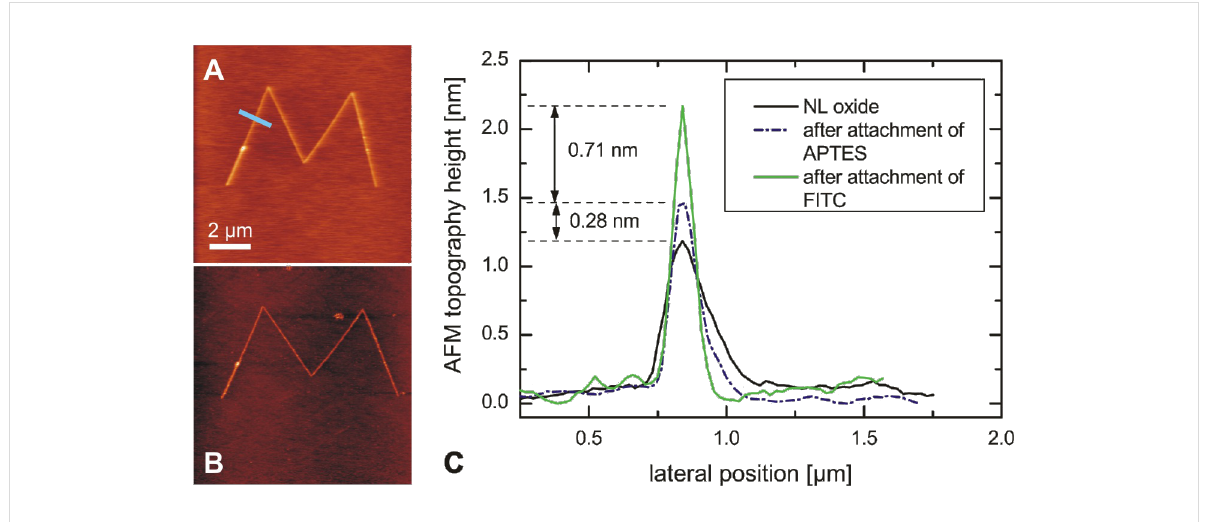
Figure 5: (A) and (B) AFM height images of LAO oxide line structures before any functionalization (A) and after binding of FITC (B). (C) Height profile of an LAO oxide structure (black curve) after 6 h in 10 mM APTES solution in dry toluene under dry conditions (blue dashed curve) and after subse- quent binding of FITC in aqueous solution (green curve). The profiles were measured and averaged over a width of 20 pixels along the path indicated by the blue line in Figure